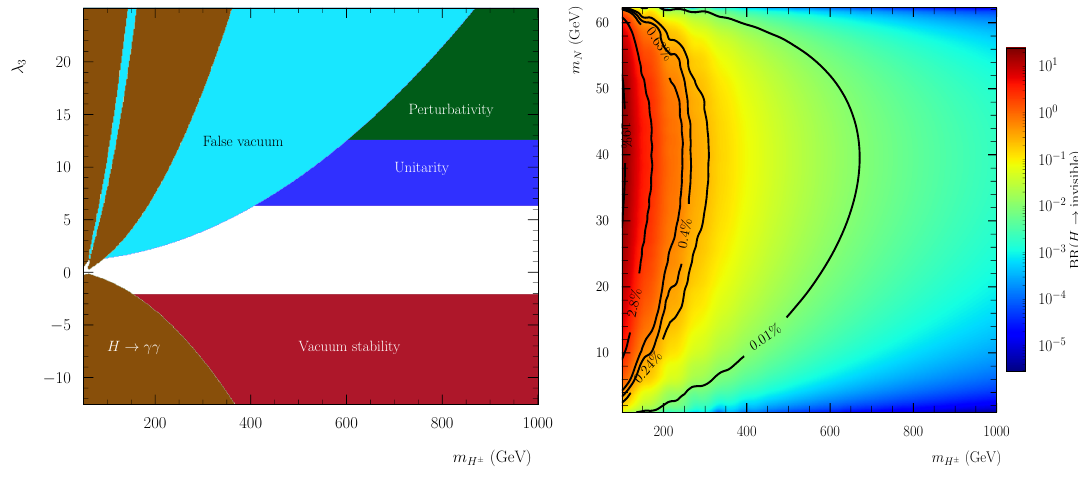
Figure 1 . Left: summary of the impact of theoretical and experimental constraints on the param- eter space of the scalar sector of the model. The constraints are depicted in the mass of the charged Higgs boson m and λ for λ = 2 . The excluded regions are shown for constraints from H → γγ 3 2 H ± (brown), from false vacuum (cyan), from vacuum stability (red), from perturbativity (green), and from perturbative unitarity (blue). The white shaded area corresponds to the allowed region of the 2D parameter space. Right: the Higgs boson invisible decay branching projected in the plane of the mass of the charged Higgs m and the mass of the Majorana DM m . The contours in N H ± solid black lines show the expected limits from HL-LHC [27], FCC-ee [28], ILC [29], CEPC [30] and FCC-hh [31] and correspond to upper bounds on BR( H → invisible) ranging from 2 . 8% to 0 . 01%